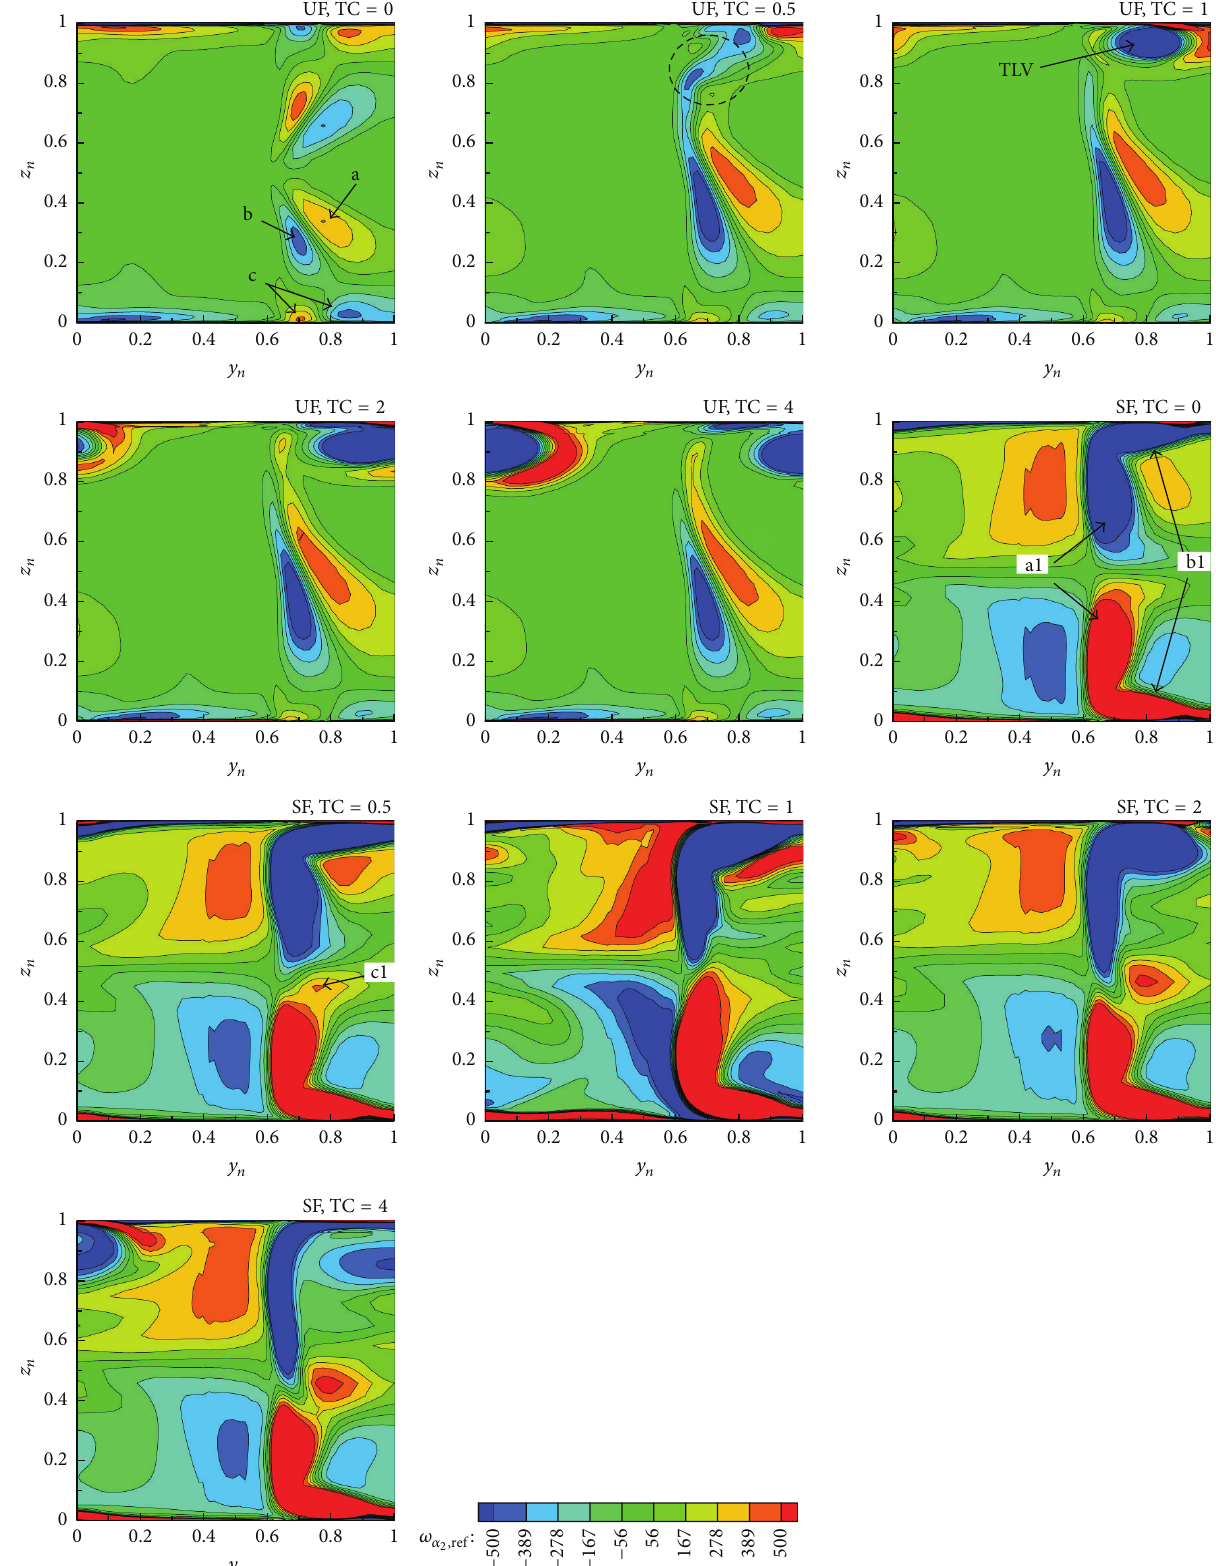
Figure 9: Vorticity along the reference outflow direction in the wake with UF and SF for TC = 0 to